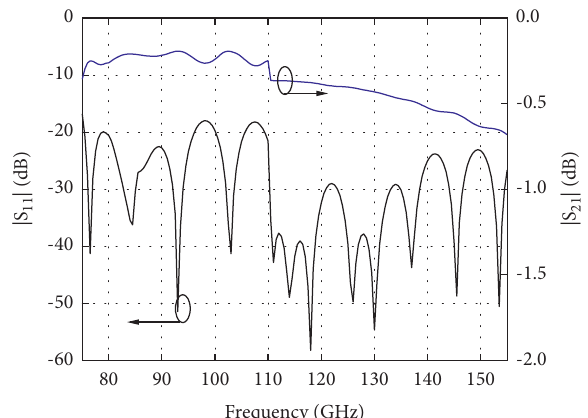
Figure 11: The simulated S parameters for the transitions between 75 and